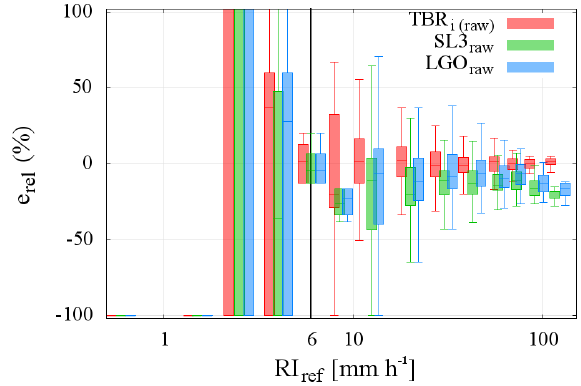
Figure 5. One-minute relative deviations ( e rel ) between the three TBRGs (including the ideal one) and the reference (OSK) when adopting the inter-tip post-processing algorithm (Ttip).